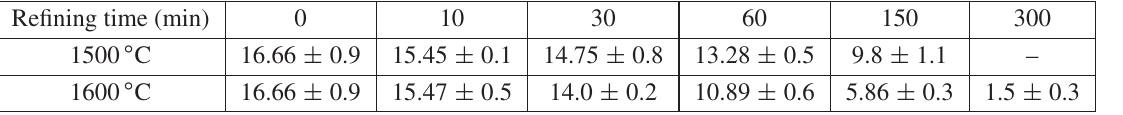
Table 1. The measured phosphorus concentrations in refined silicon by ICP-MS. The numbers are averages over three samples in